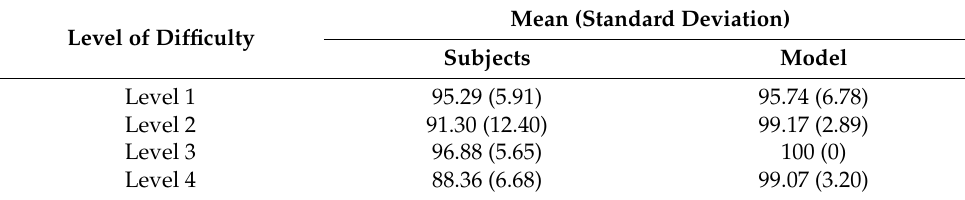
Figure 6. Task switching percentage for subjects and model data just after the ongoing subtask, when the alternative task still remained. Table 3. Task switching percent (%) for subjects and model data just after the ongoing subtask, when the alternative task still remained.